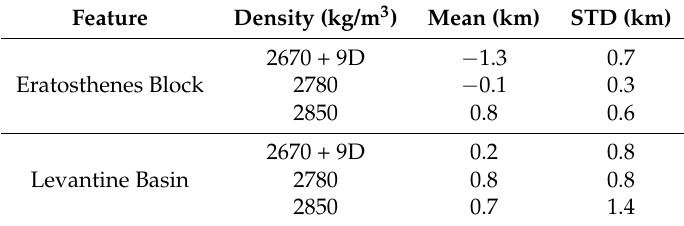
Table 1. Differences between seismic profiles and Moho depths derived from gravity inversion executed for different density values for the Eratosthenes Block and Levantine